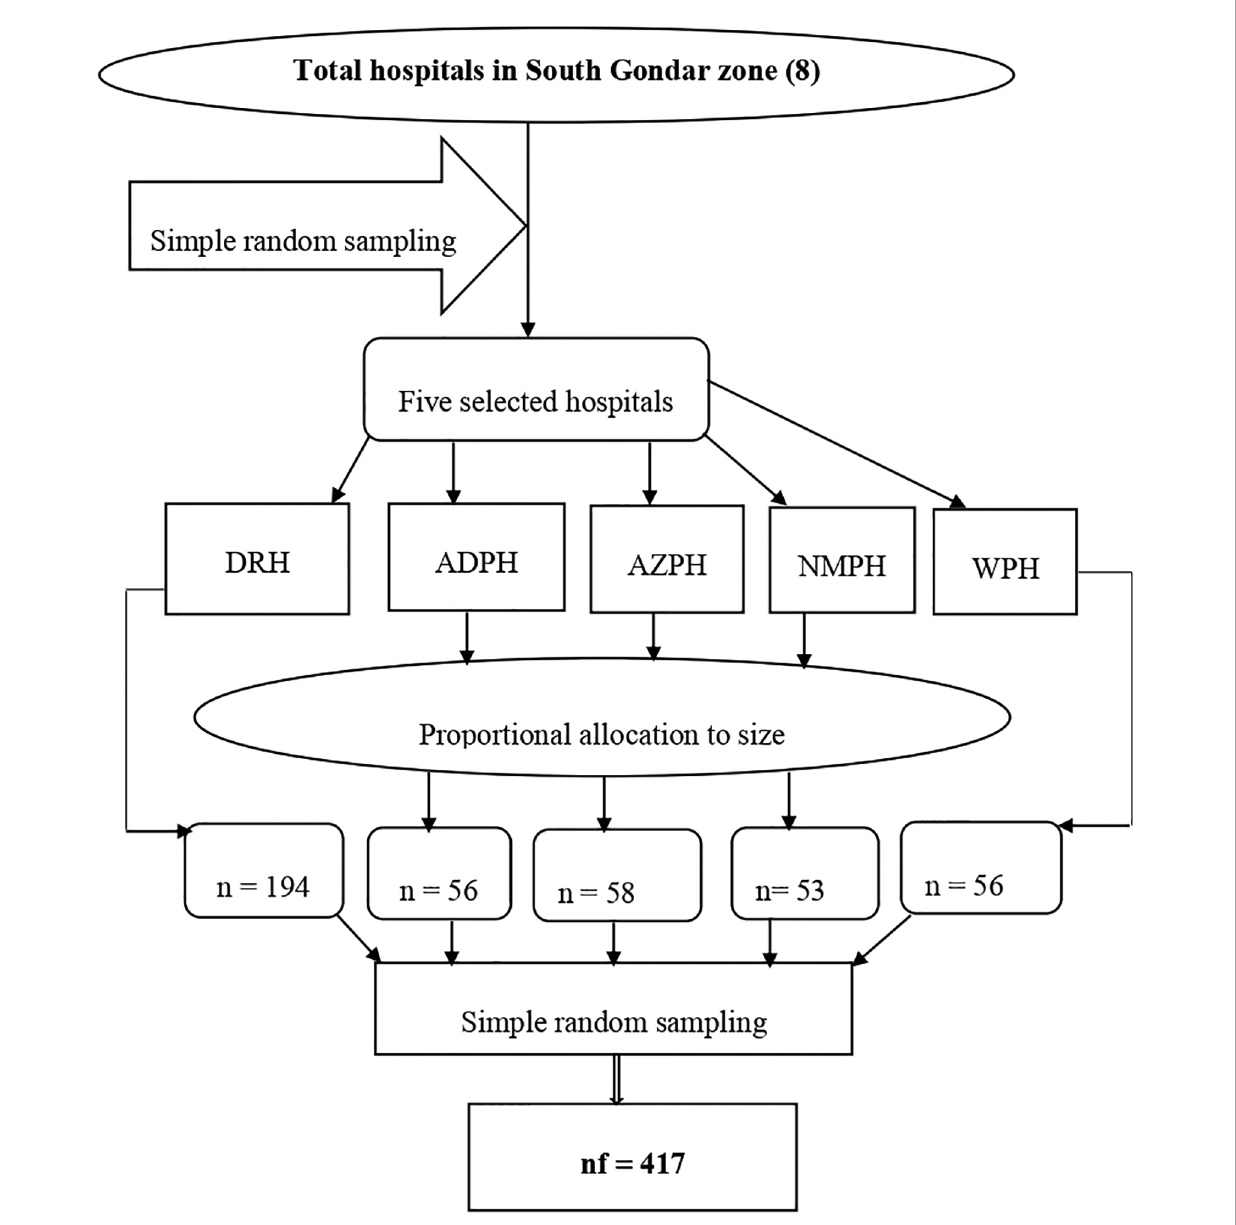
FIGURE 1 Schematic presentation of the sampling procedure among mothers in South Gondar zone hospitals, Northwest Ethiopia, 2020. DTGH, Debre Tabor Referral Hospital; AZPH, Addis Zemen Primary Hospital; NMPH, Nifas Mewucha Primary Hospital; WPH, Wogeda Primary